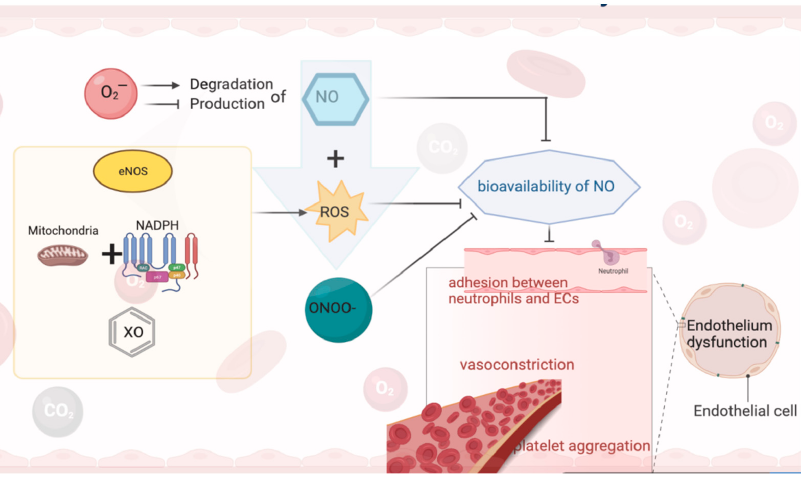
Figure 1. NO and endothelium